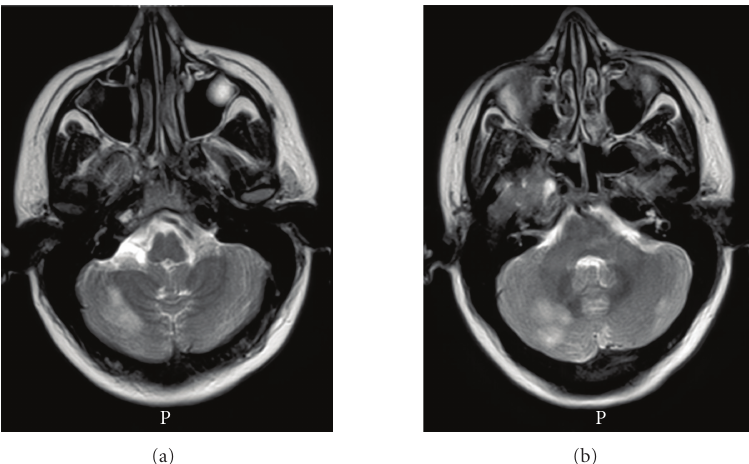
Figure 1: Axial T2-weighted MRI shows areas of hyperintense signal in both the right and left cerebellar hemispheres. Findings in this MRI had led to the initial false diagnosis of an ischemic stroke in the posterior circulation.